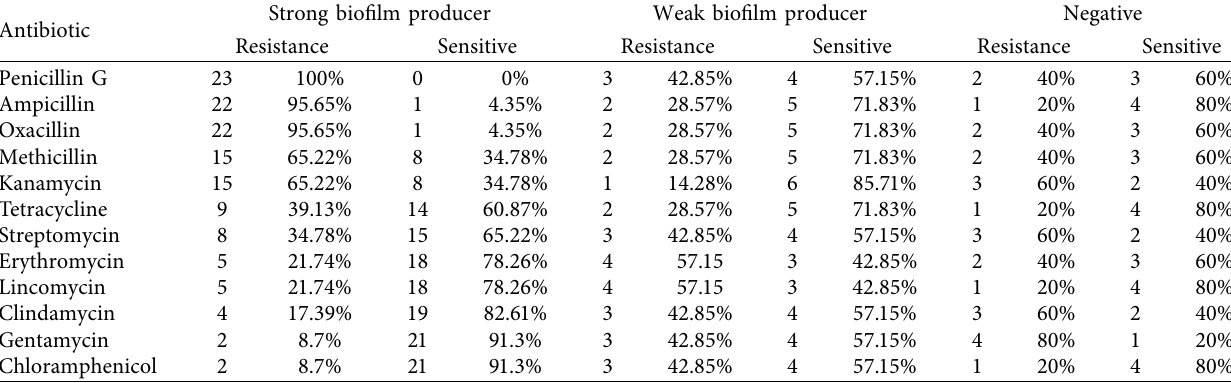
Table 4: Antibiotic resistance pattern based on biofilm reaction in S. aureus strains isolated from row cow milk.